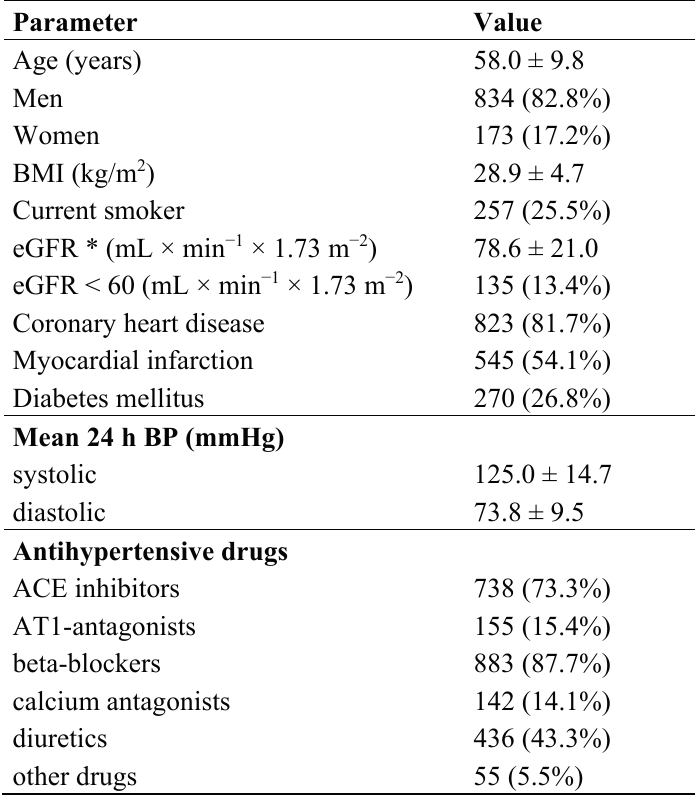
Table 1. Characteristics of study cohort ( N =